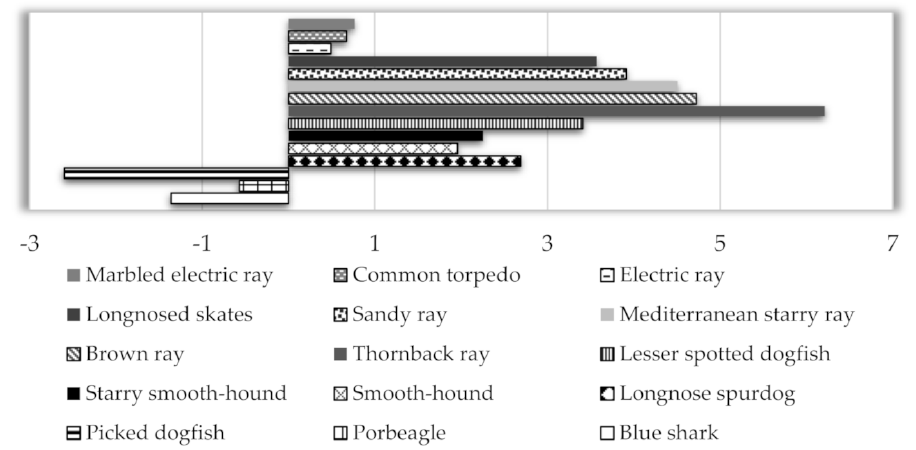
Figure 2. Selenium health benefit value (HBV Se ) of the studied fish